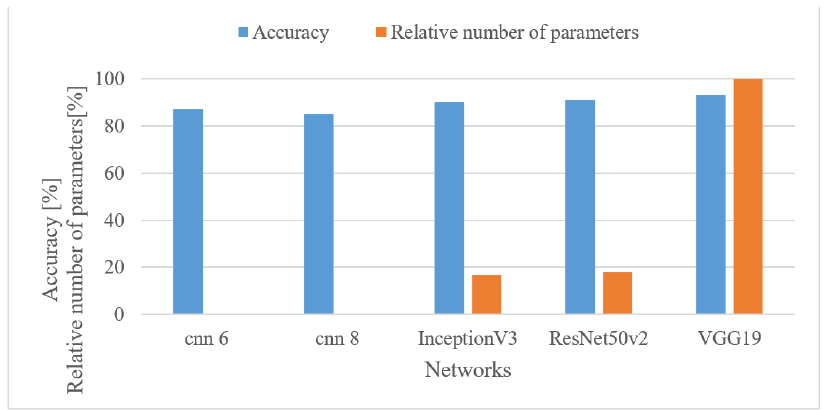
Figure 23. Accuracies and relative numbers of trainable parameters for custom 6- and 8-layer CNNs (CNN 6, CNN 8), Inception V3, VGG19, and ResNet50v2, and 100 Hz-17.5 kHz 64 MFBs.